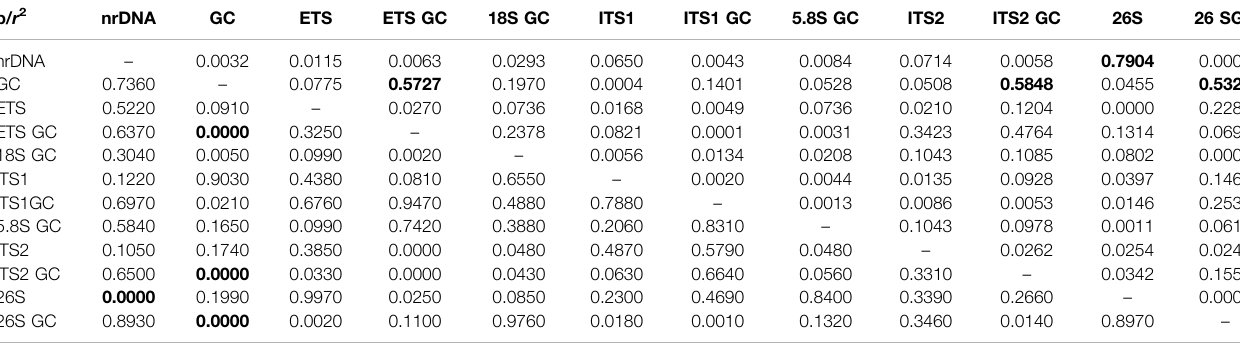
TABLE 3 | Correlations between main characteristics of Eriobotrya and Rhaphiolepis nrDNA. p/ r 2